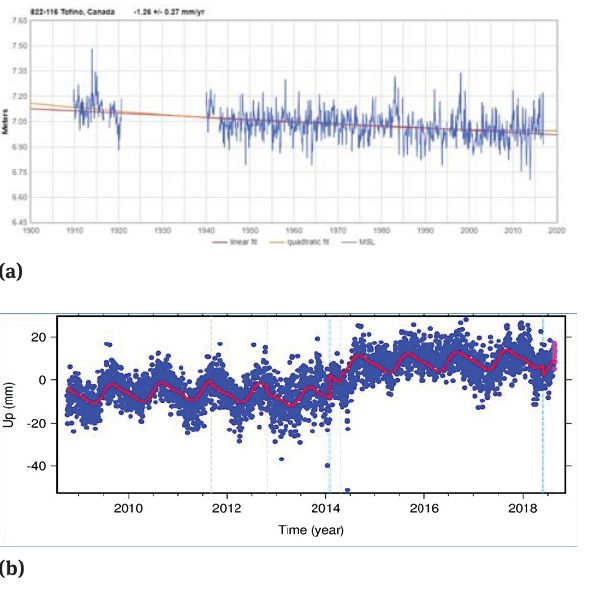
Figure 12: (a) MSL data for Friday Harbor, WA, USA. Image repro- duced modified after [4]. (b) GNSS time series for SC02. Image reproduced modified after NGL. This GNSS antenna is almost co- located with the tide